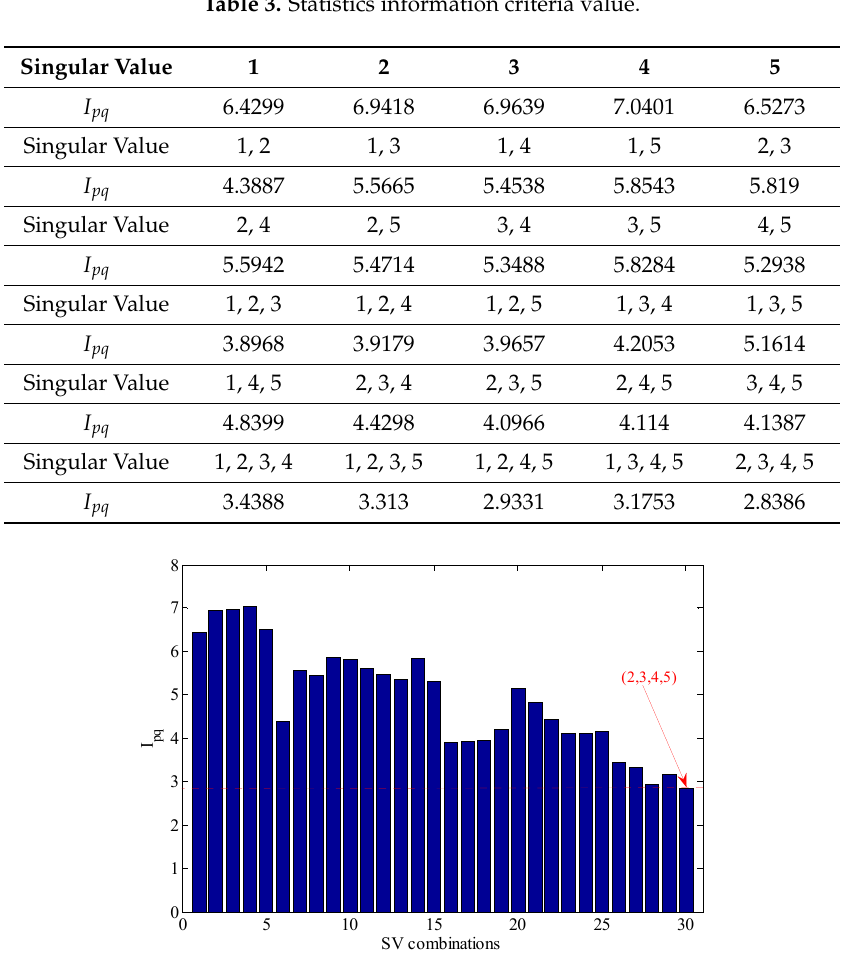
Figure 11. Statistics information criteria value.